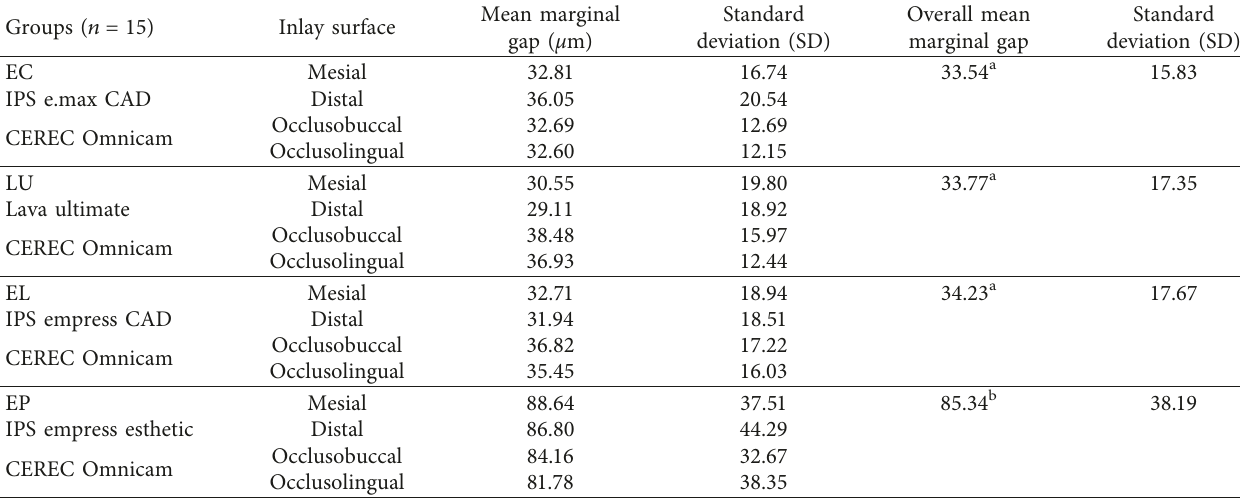
Table 1: Results of the mean marginal gap. Standard deviation (SD) of the impression methods evaluated at each surface and overall mean marginal gap and SD of each impression method Groups ( n �